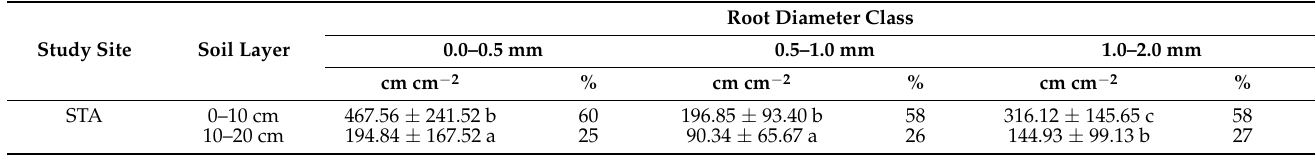
Table 5. Fine root length (mean ± SD) for different root diameter classes and soil layers in three study sites: Starogr ó d (STA), Wielka K˛epa (WK), and Ostr ó w Panie´nski (OP). The means are for all sampling times. Within each root diameter class, different letters indicate significant differences among depths at the same study site ( p < 0.05, Tukey’s